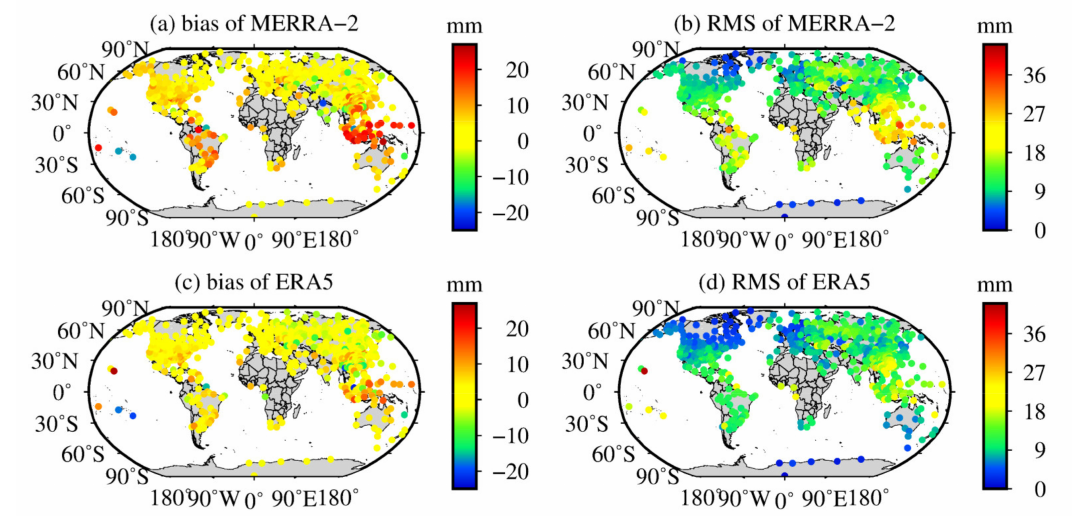
Figure 12. Distributions of the ( a , c ) bias and ( b , d ) RMS of the ZWD values calculated from ERA5 and MERRA-2 pressure- level data with respect to the radiosonde ZWD from 2016 to 2017.